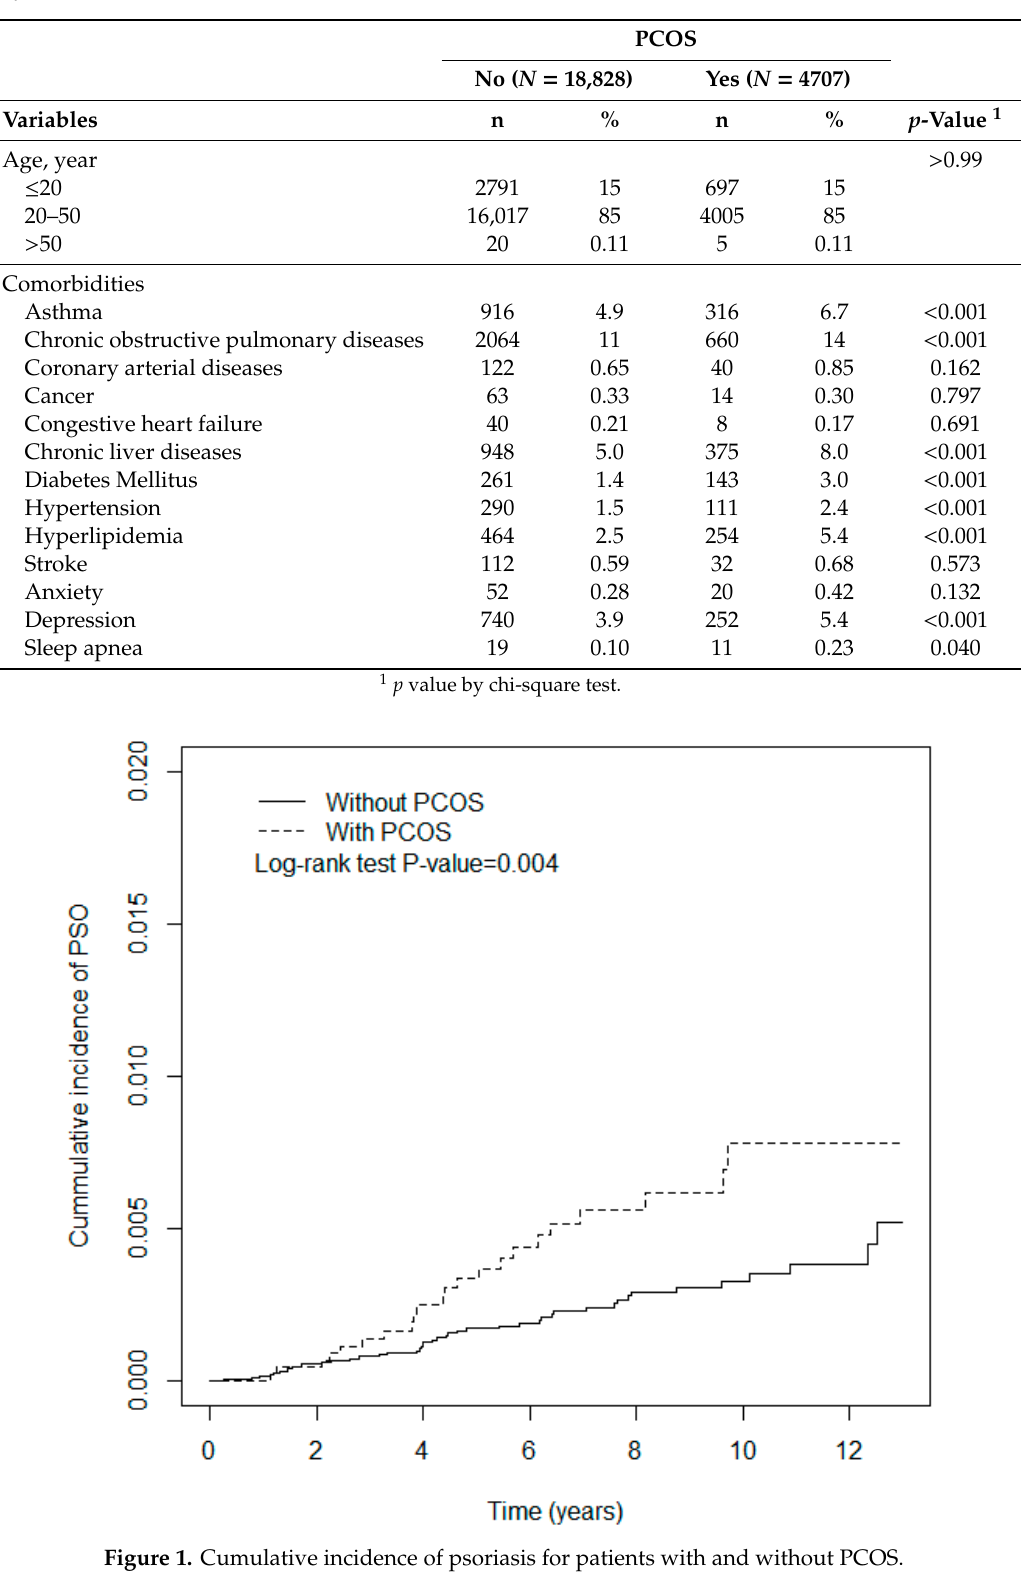
Table 1. Baseline characteristics and comorbidities of patients with and without polycystic ovary syndrome (PCOS).